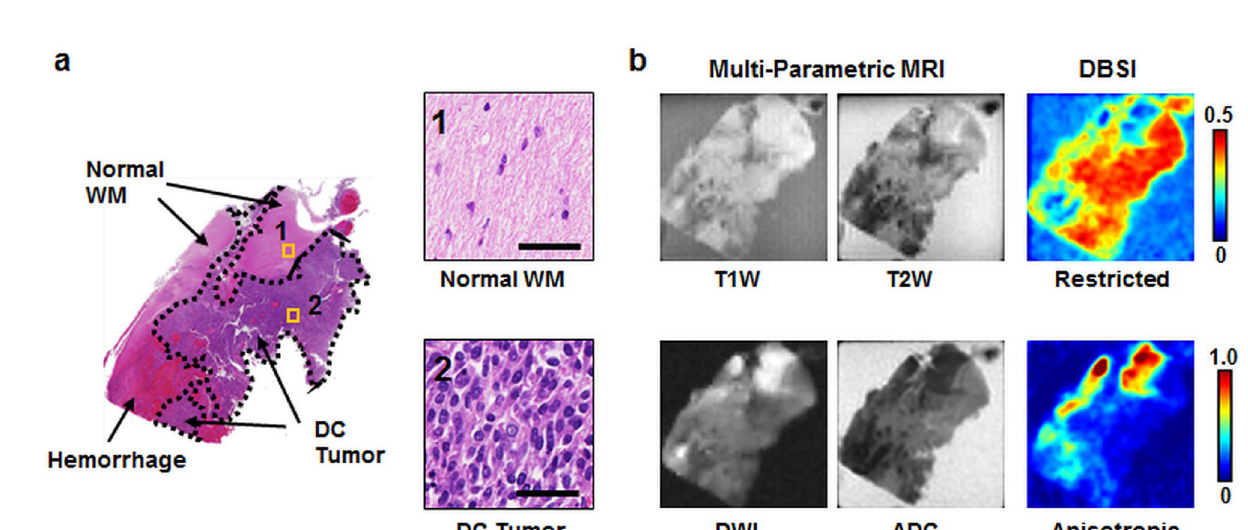
Figure 3. A representative tissue block was imaged with ex vivo MRI, followed by histologic processing and evaluation. ( a ) H&E image of a sectioned specimen after ex vivo MRI with regions of white matter, densely cellular tumor and hemorrhage outlined for assessing the efficacy of metrics derived by multi-parametric MRI and DBSI. The expanded region of densely cellular tumor features characteristically increased cellularity. Scale bar measures 50 um. ( b ) T1W and T2W MRI did not distinguish densely cellular tumor region from white matter or hemorrhage. Most strikingly, diffusely cellular tumor region exhibited lower DWI and higher ADC countering the conventional wisdom that higher tumor cellularity is associated with restricted diffusion. WM white matter, DC tumor densely cellular